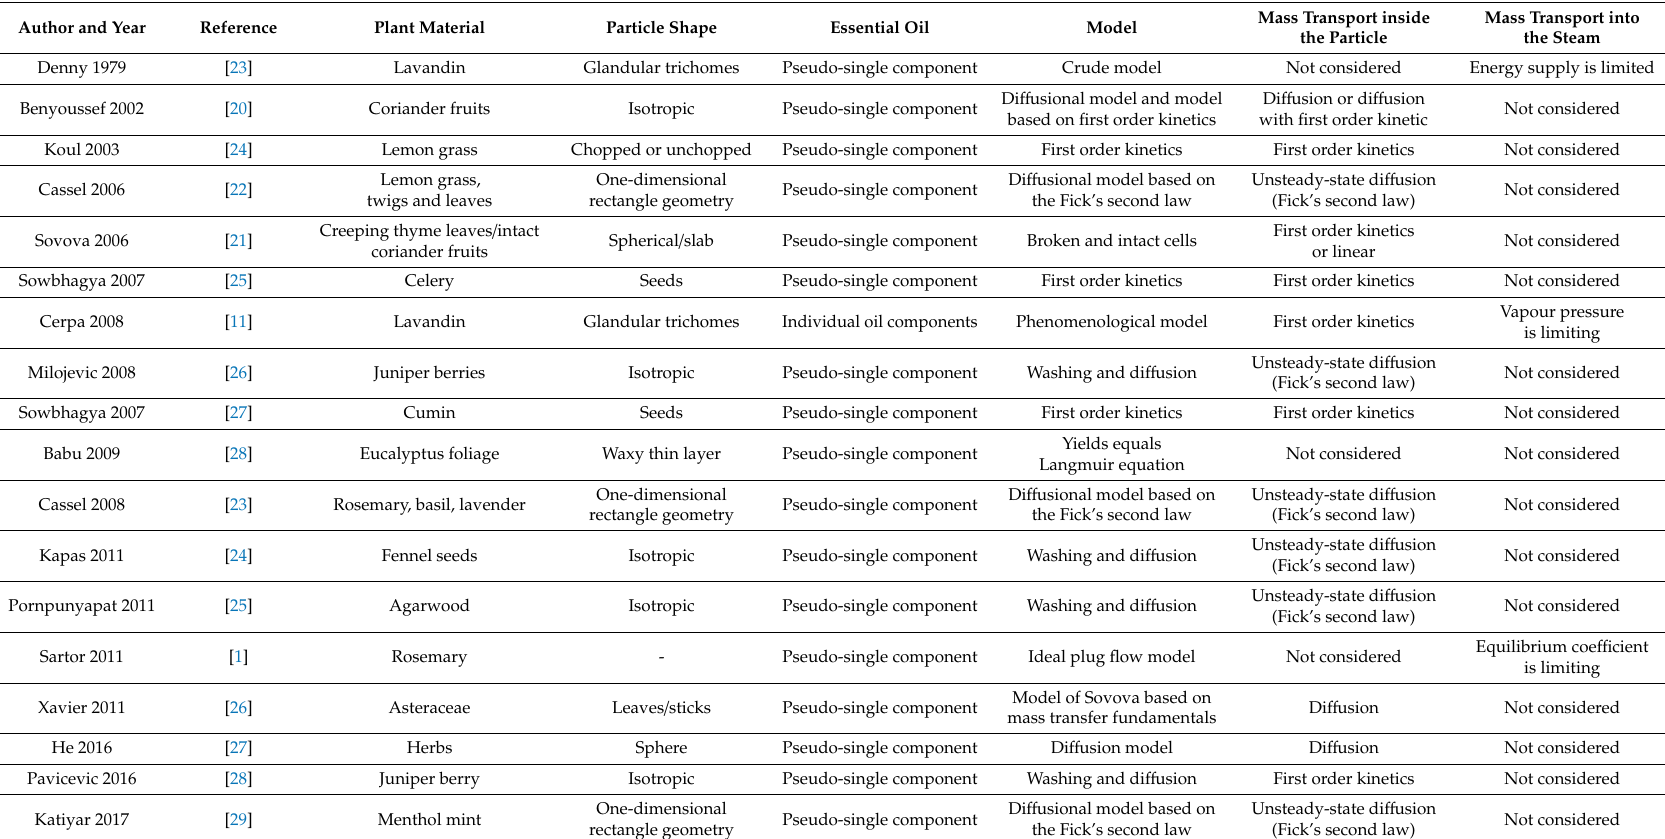
Table 2. Overview of modelling